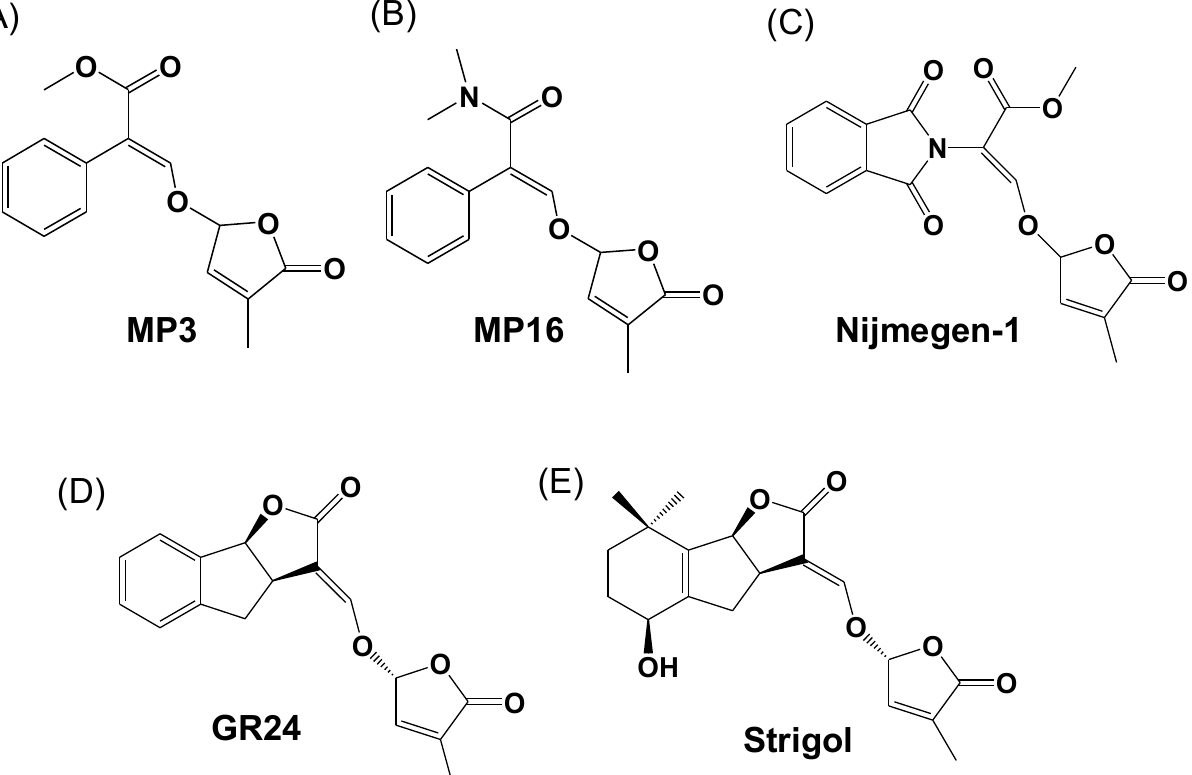
Figure 1. Chemical structures of strigolactone analogs ( A ) MP3, ( B ) MP16, ( C ) Nijmegen-1, ( D ) GR24, and ( E ) strigol, a natural strigolactone.